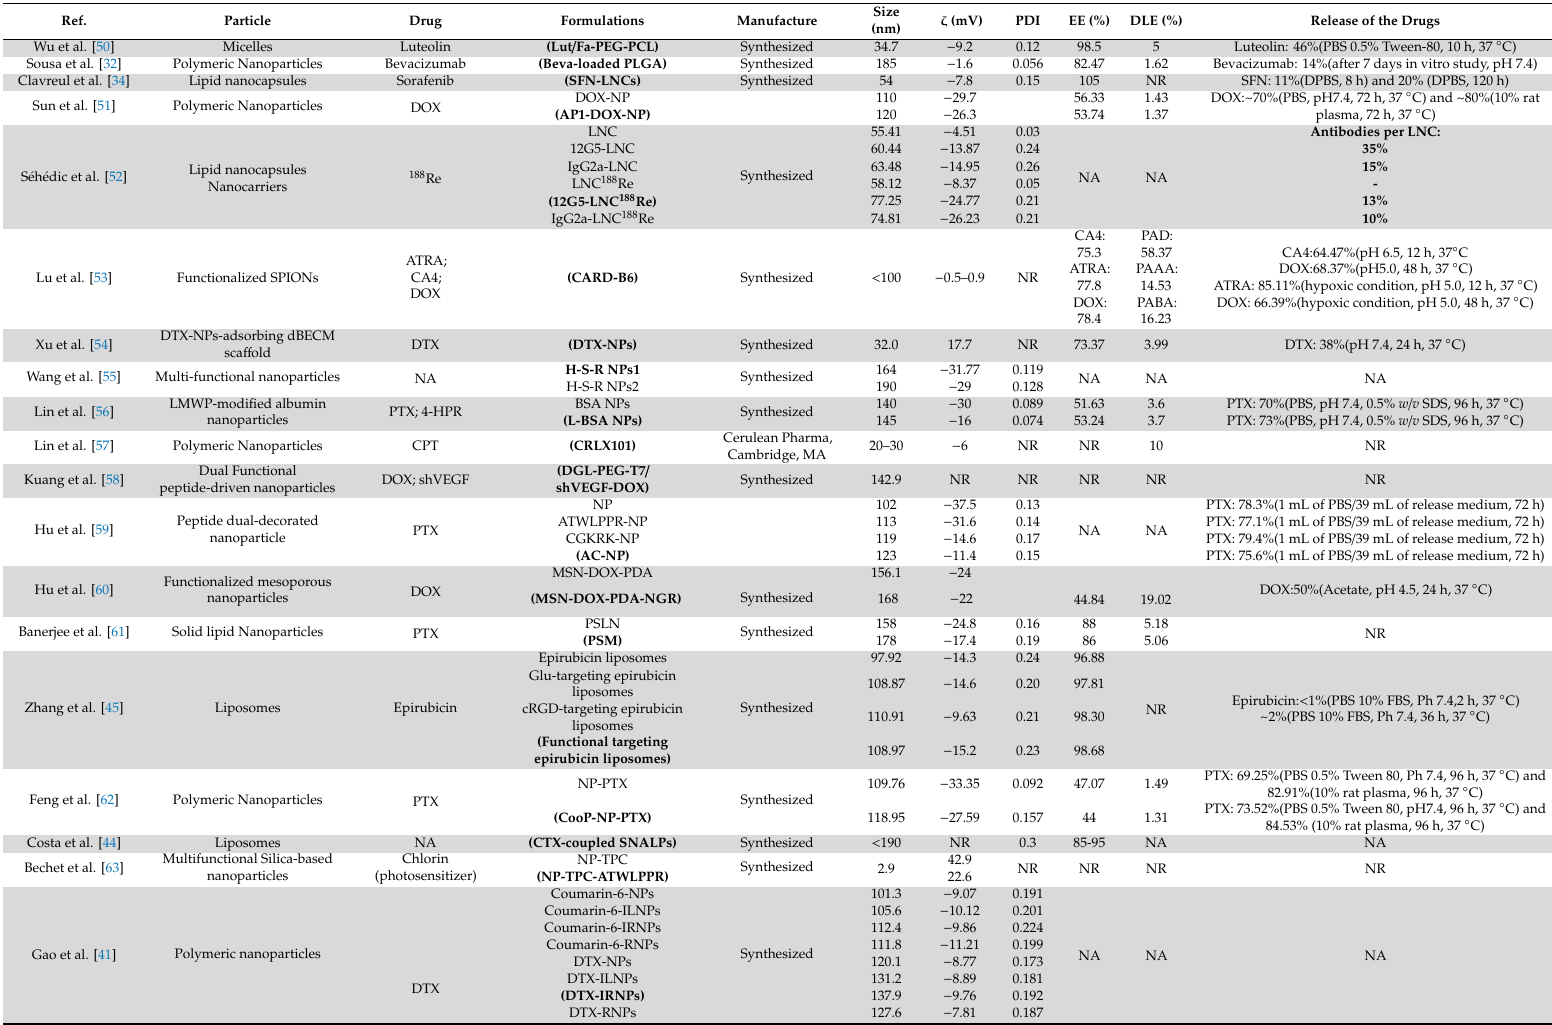
Table 3. Nanoformulations used in the antiangiogenesis